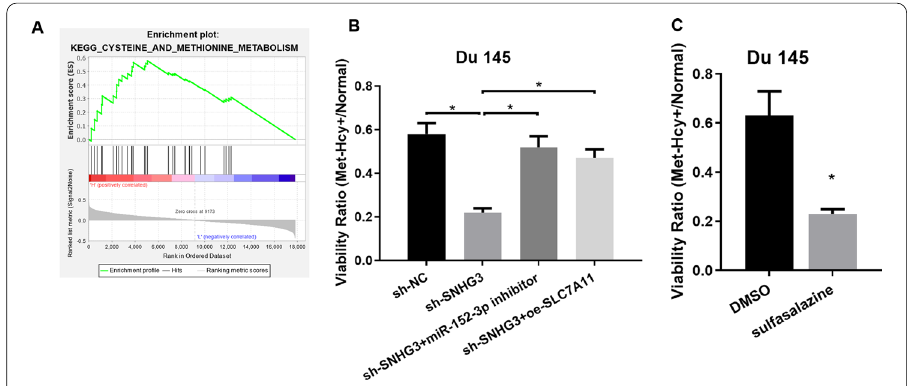
Fig. 6 SNHG3/miR-152-3p/SLC7A11 modulatory axis can influence methionine dependence of PCa cells. A GSEA enrichment analysis of SLC7A11; B CCK-8 measured methionine dependence of PCa cells in each transfection group (sh-NC, sh-SNHG3, sh-SNHG3 miR-152-3p inhibitor, sh-SNHG3 oe-SLC7A11). The + + experiment was repeated 3 times, * p < 0.05. C CCK-8 measured methionine dependence changes of PCa cells during sulfasalazine treatment. The experiment was repeated 3 times, * p < 0.05